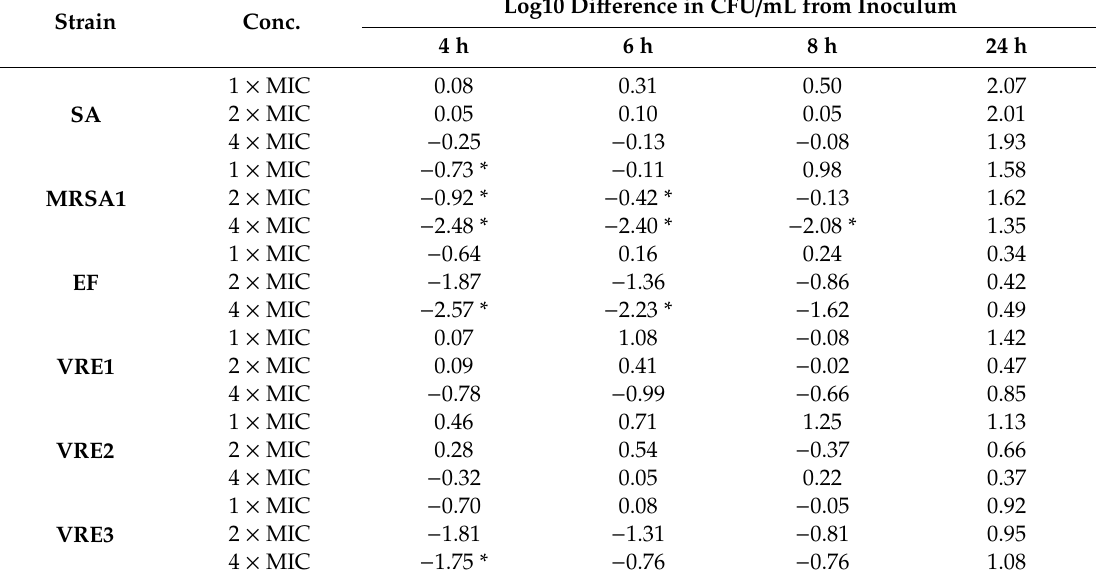
Table 5. Change in viable counts (log10 CFU / mL) of staphylococci and enterococci strains following incubation for 24 h with compound 1h . Strain Conc.